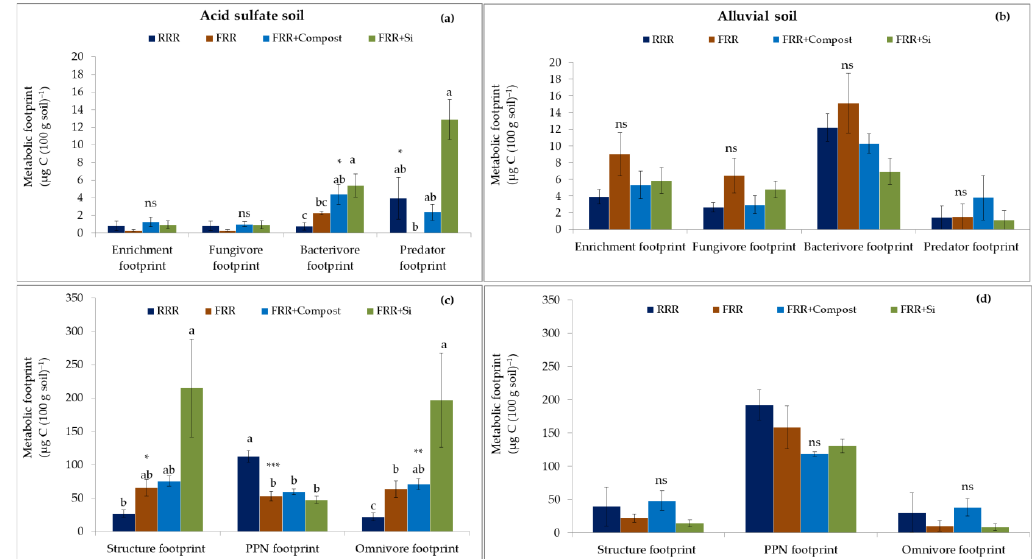
Figure 5. The metabolic footprints (µg C (100 g soil) –1 ) of the nematode community among treatments in acid sulfate soil ( a , c ) and alluvial soil ( b , d ). Value is mean and standard error ( n = 4). Different letters indicate the significant differences among treatments at * p < 0.05; ** p < 0.01; *** p < 0.001; ns, not significant. RRR, triple–rice system; FRR, fallow and double– rice; FRR + Compost, fallow and double–rice with 3 Mg ha –1 sugarcane filter cake compost; FRR + Si, fallow and double– rice with 100 kg ha –1 silicate fertilizer.